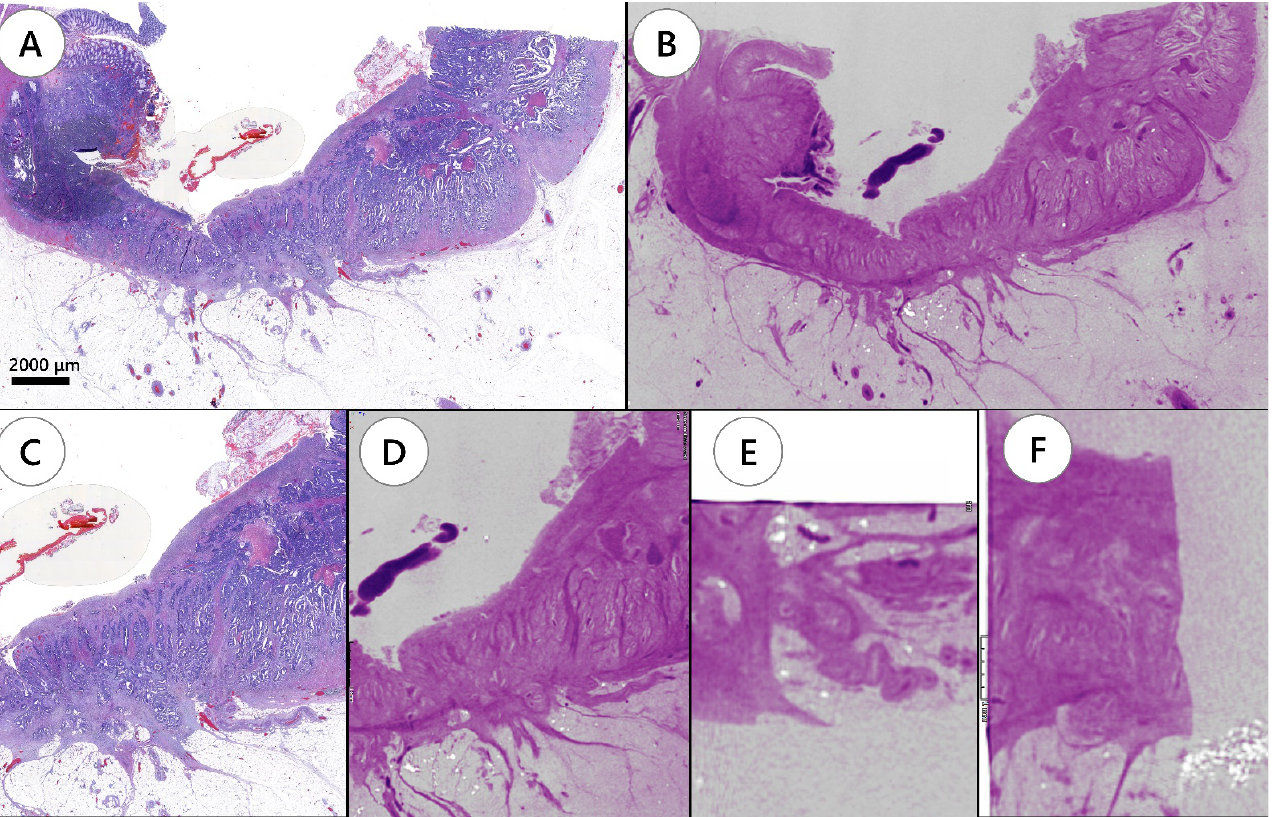
Figure 1. Tumor depth evaluation by conventional hematoxylin and eosin slide image and whole-block imaging. ( A ) Hematoxylin and eosin slide showing a tumor invading the subserosa. ( B ) Whole-block imaging showing subserosa invasion on the same plane of the corresponding hematoxylin and eosin slide. ( C ) Magnifying image of invaded area. ( D ) The corresponding image of whole-block imaging. Serial images are applicable for whole-block imaging through the formalin- fixed paraffin-embedded block. ( E , F ) Whole-block imaging showing serial images in three dimensional directions.